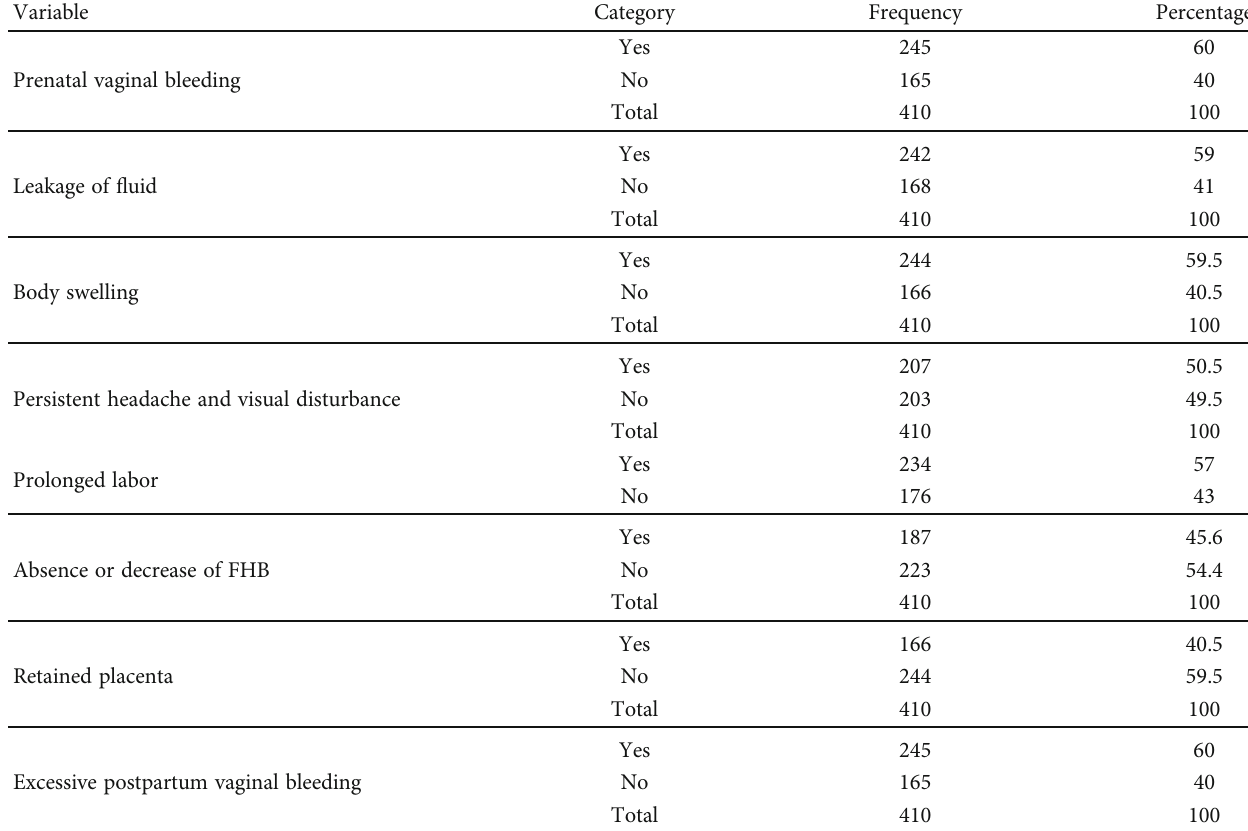
Table 3: Knowledge of the obstetric danger signs among mothers aged 15 – 49 years in southeastern, Tigray Region, North Ethiopia, June 2021 ( n = 410